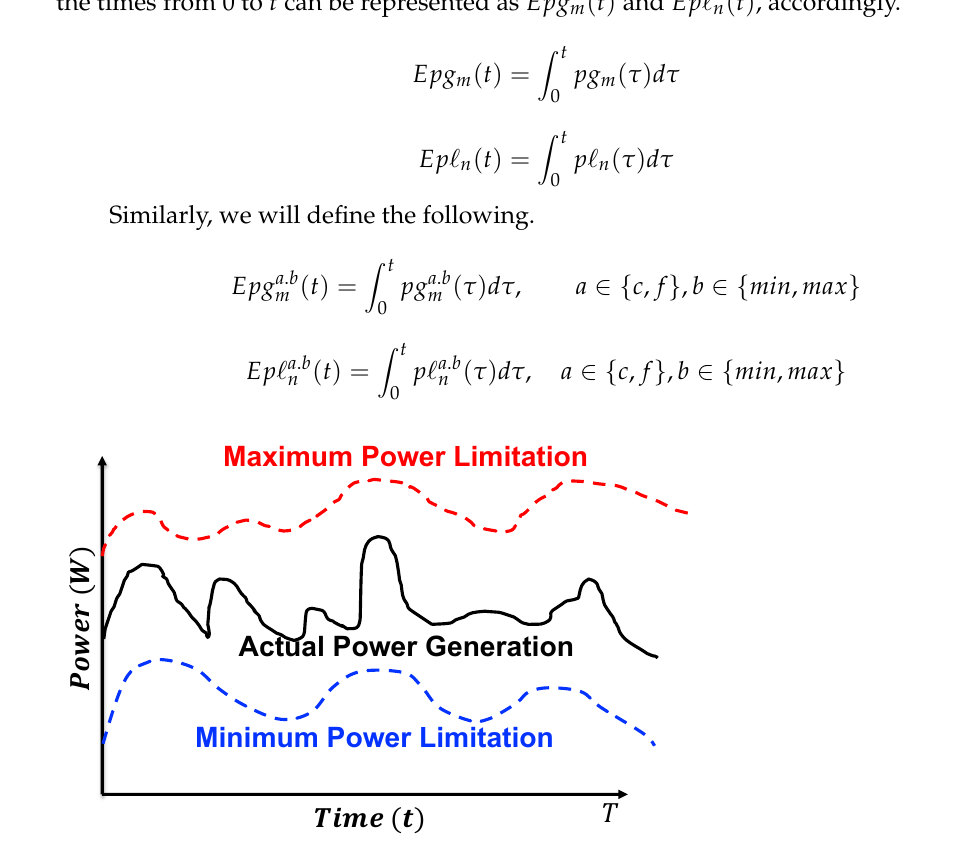
Figure 4. Historic data based power supply limitations